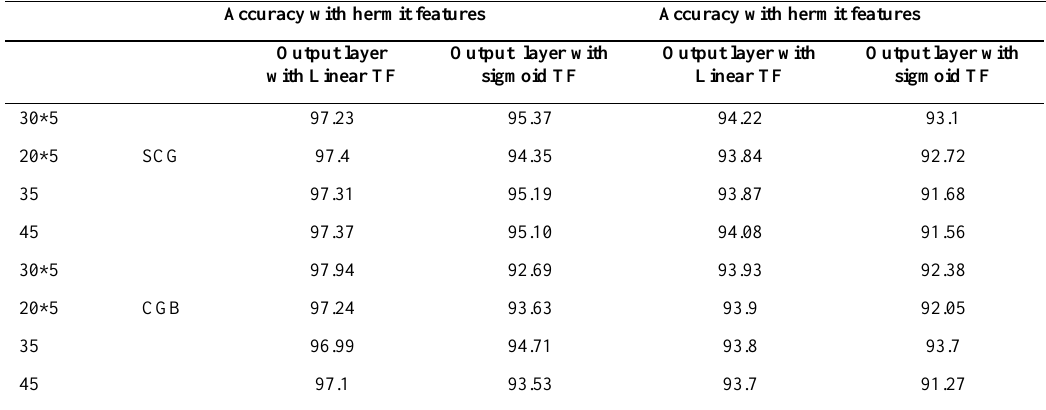
Table 3. Comparative results for networks with linear or sigmoid transfer function in the output